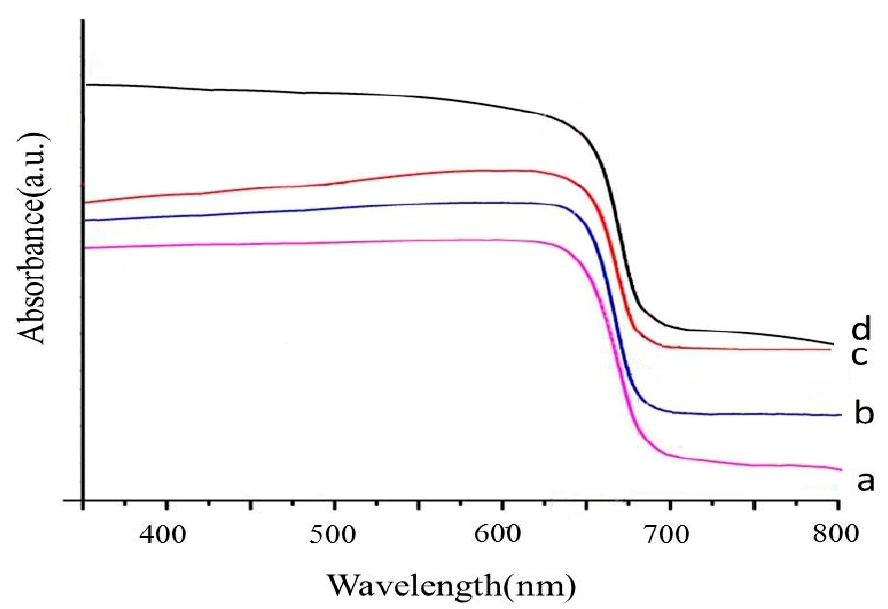
Figure 6. DRS spectra of ( a ) pure CdSe, ( b ) 4%Tb- doped CdSe, ( c ) 8%Tb- doped CdSe, and ( d ) 12% Tb-doped CdSe nanoparticles.